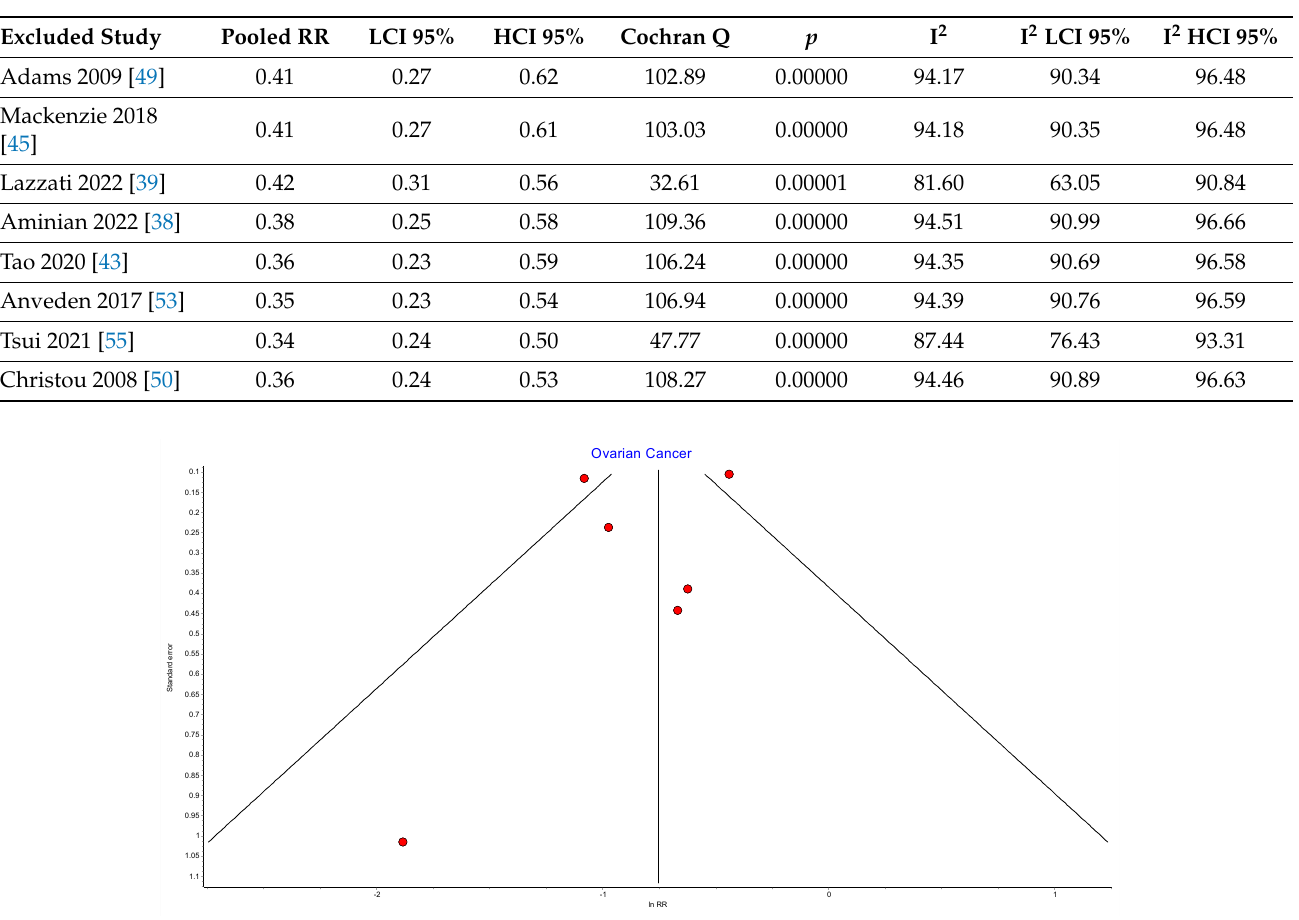
Table A7. Endometrial cancer random effects model sensitivity analysis.